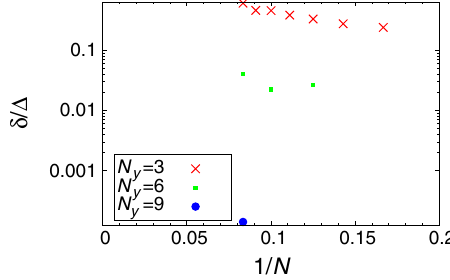
FIG. 4. Ratio between the energy spread (cid:5) of the 3-fold ground-state manifold and the energy gap (cid:2) for various system sizes and aspect ratio. The spread is defined as the difference between the highest energy and the lowest energy of the 3-fold ground-state manifold. In each case, N x ¼ 3 N=N y .